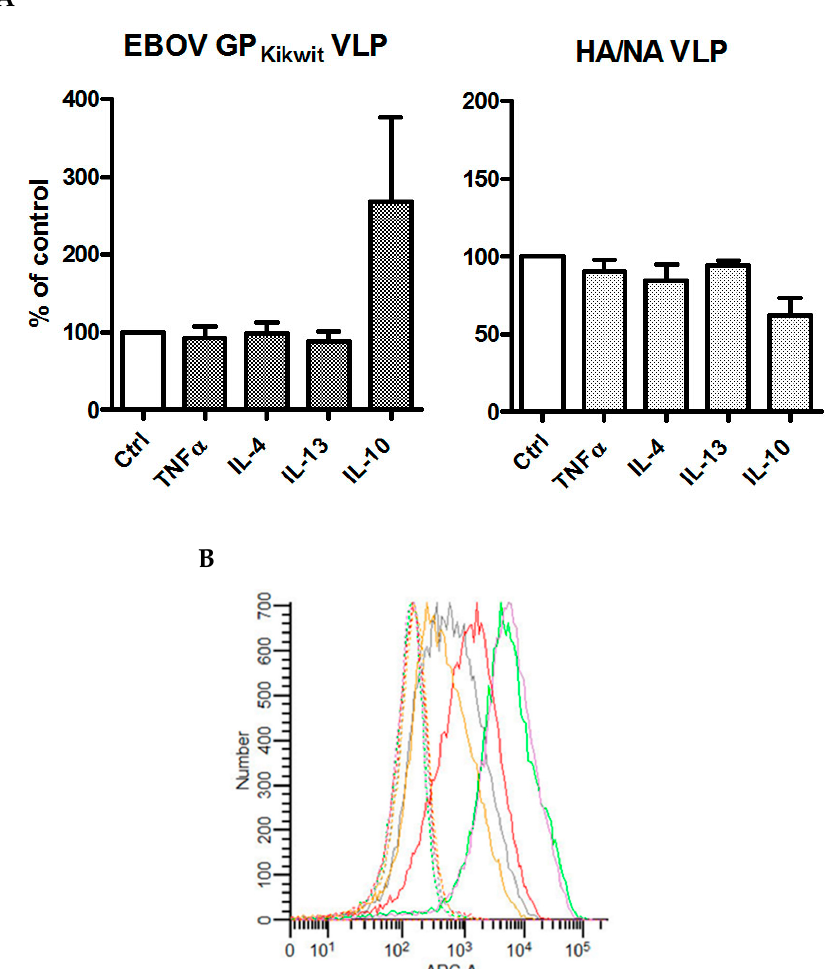
Figure 1. ( A ) IL-10, but not TNF- α , IL-4 or IL-13, significantly enhance EBOV Kikwit glycoprotein(s) (GP) pseudotyped virus-like particles (VLP) entry in primary human monocyte-derived macrophages (MDM). MDM from three healthy donors were pre-treated with TNF- α , IL-4, IL-13 or IL10 (all at concentrations of 20 ng / mL) for 48 h prior to incubation with EBOV Kikwit GP or influenza hemagglutinin / neuraminidase